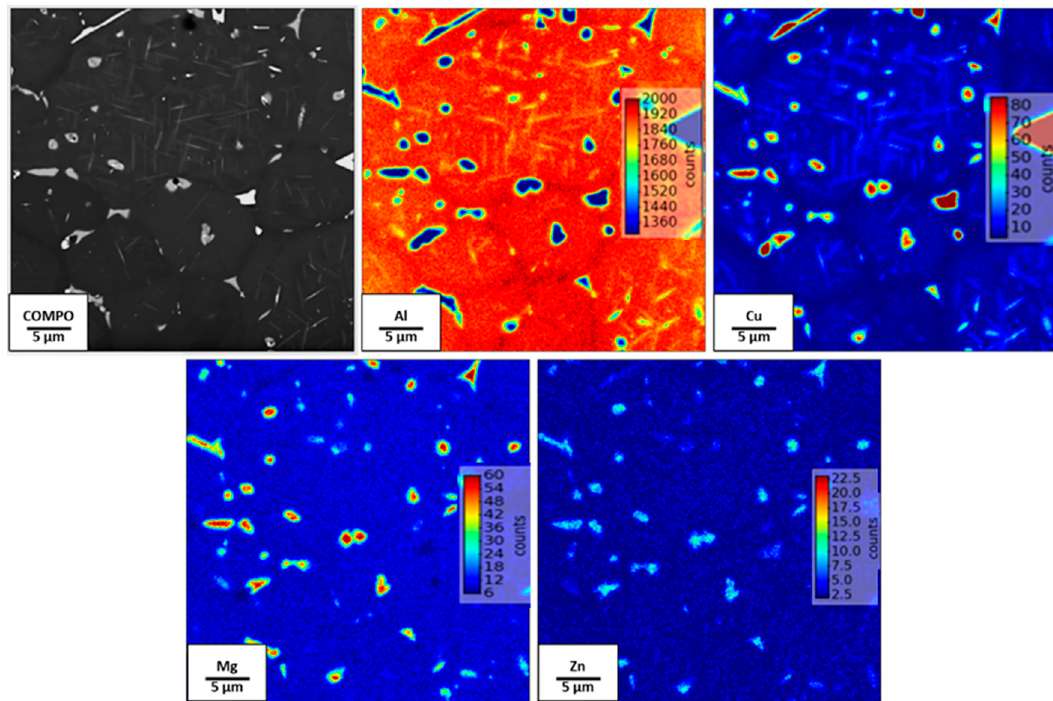
Figure 8. SEM/EPMA maps of preheat-treated sample (500 °C) showing Cu-, Mg- and Zn-enriched phases, and PFZ as well as T 1 and T B plates